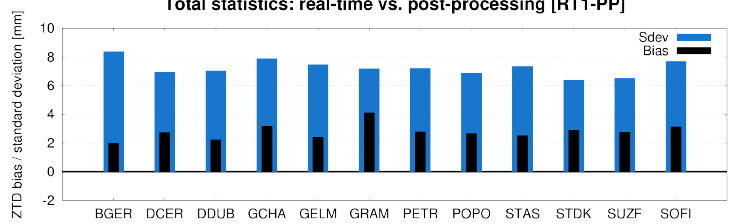
Figure 3. ZTD statistics (real-time minus post-processing) for all stations and the period May– September